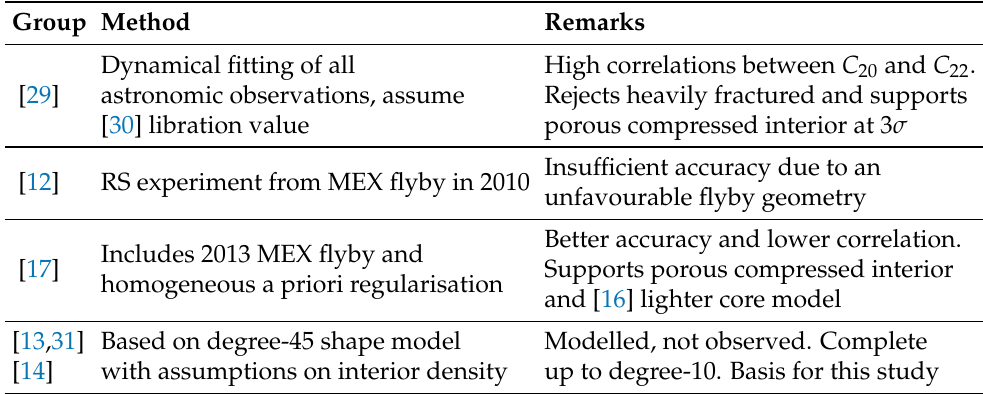
Table 1. Working models for Phobos’ gravity